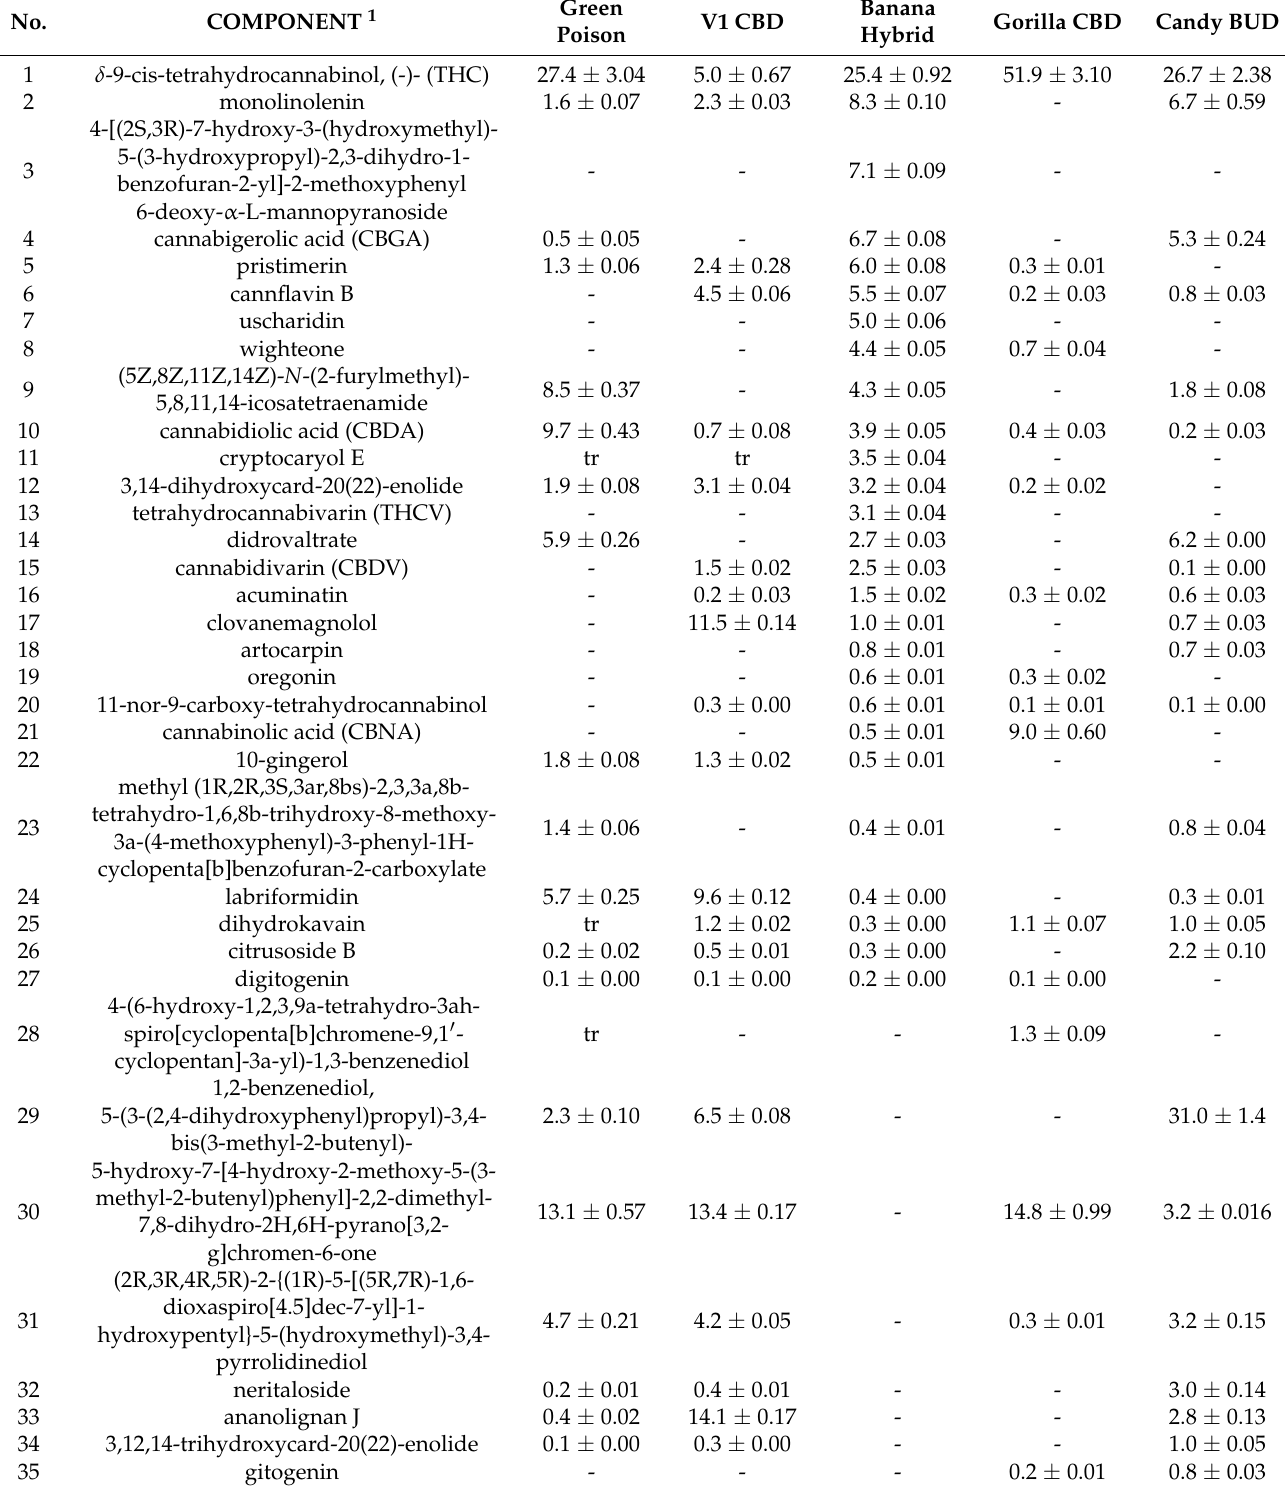
Table 2. Chemical non-volatile composition (percentage mean value ± standard deviation) of Cannabis sativa L.